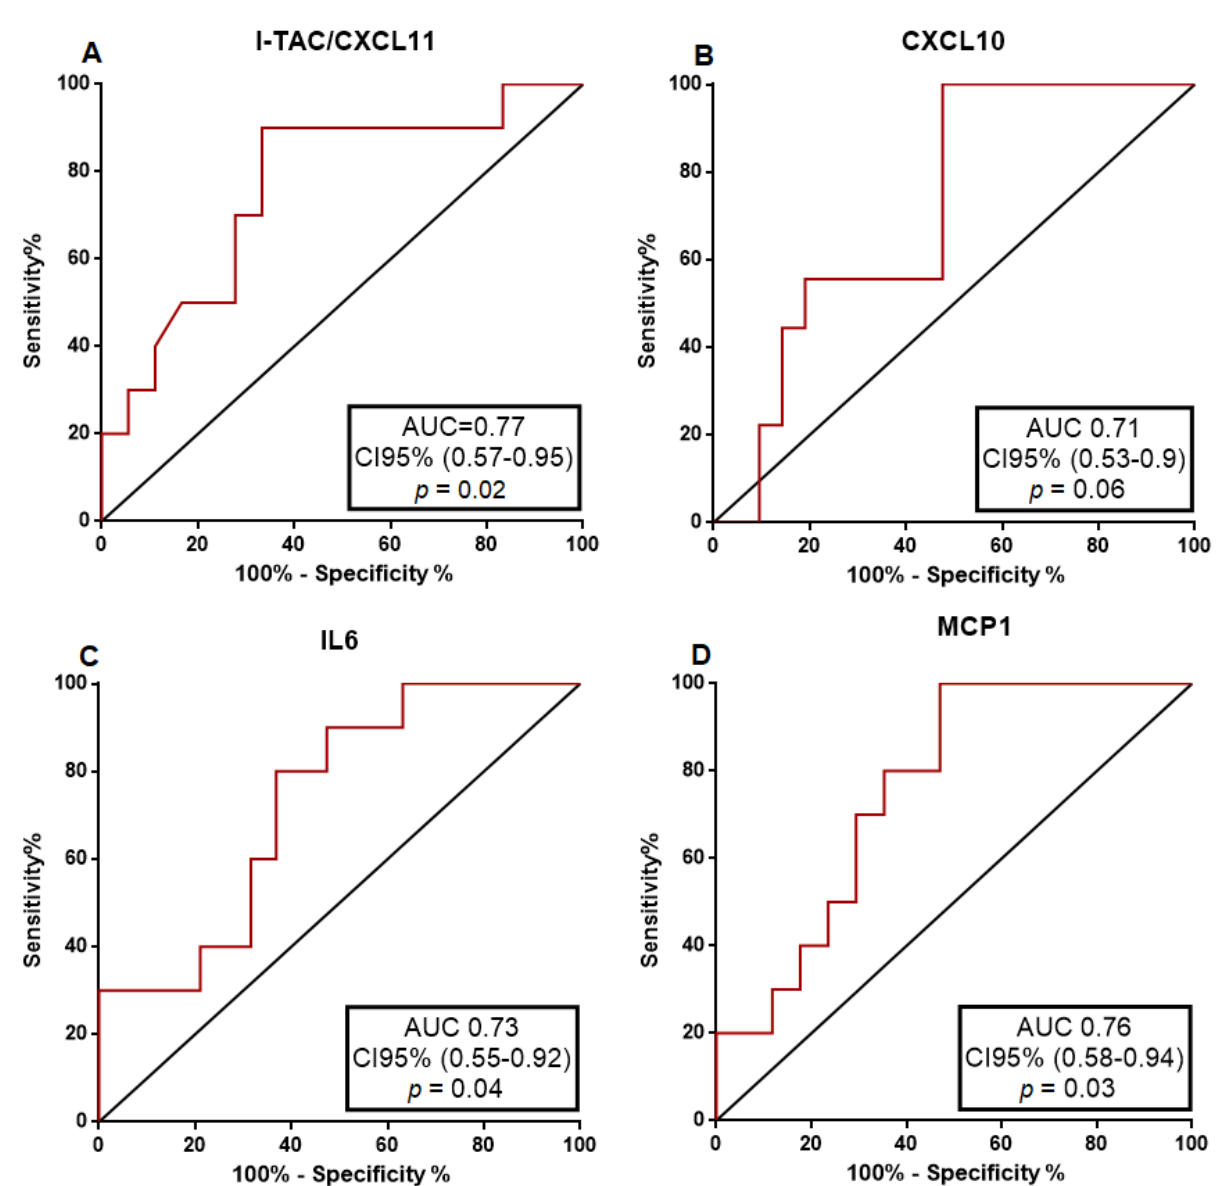
Figure 2. The ROC curves of CXCL11 ( A ), CXCL10 ( B ), IL-6 ( C ) and MCP-1 ( D ) in the distinction of acute tubulointerstitial nephritis from acute tubular necrosis. AUC—Area under the curve; CI95%—Confidence interval 95%.